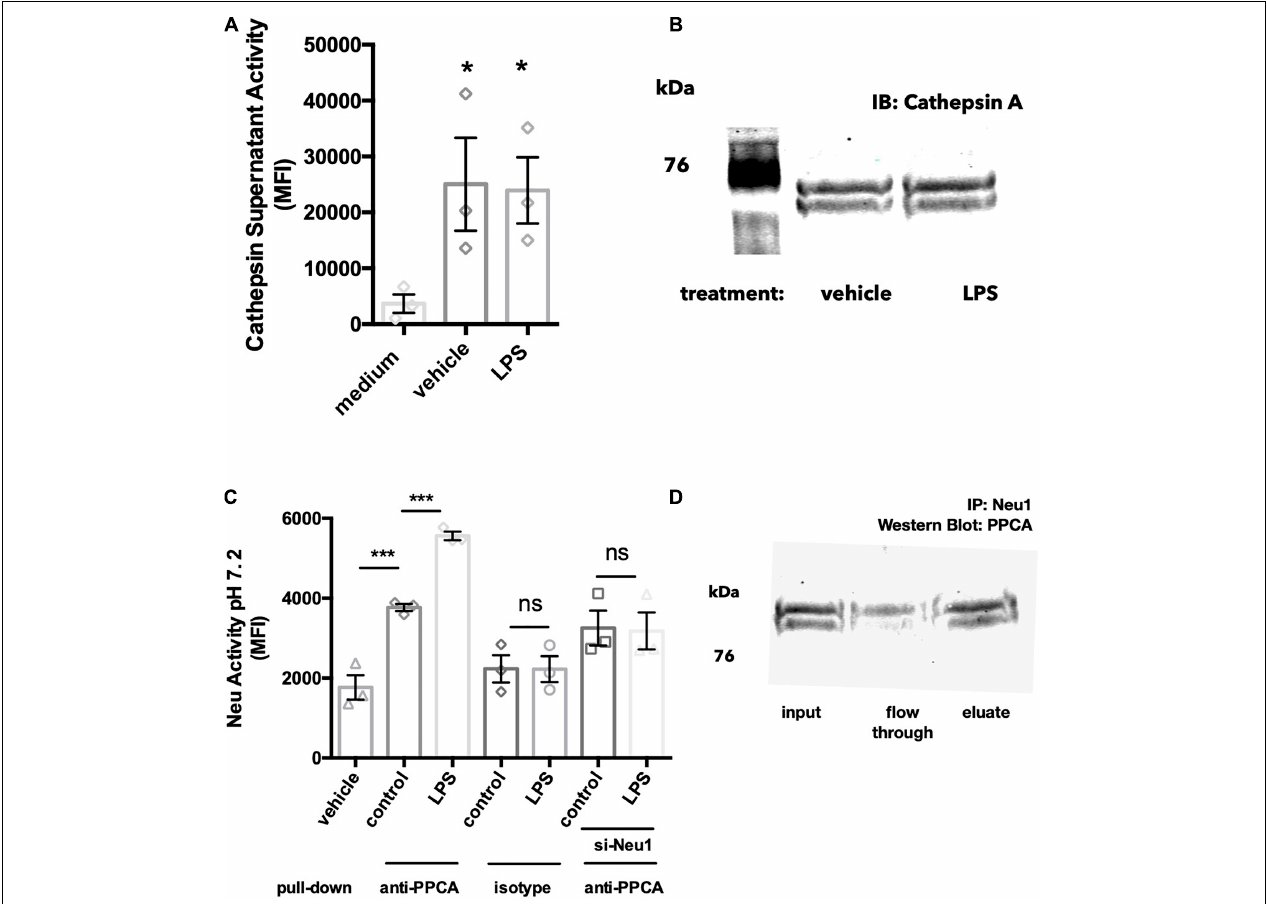
FIGURE 3 | Neu1 is released together with protective protein cathepsin A (PPCA). (A) Cathepsin activity assay measured by cleavage of substrate Z-Phe-Arg- 7-amido-4-methylcoumarin (Z-Phe-Arg-AMC) in acidic buffer (pH 4.5). BV-2 cells were treated with vehicle or LPS (100 ng/ml) for 18 h and supernatants were tested for cathepsin activity. Medium indicates a DMEM-only control with no cells added. Data presented as mean fluorescence intensities of at least 3 independent experiments ( ± S.E.M). Statistics: one-way ANOVA with Tukey’s post hoc analysis * p < 0.05 versus medium. (B) Western blot of 20-fold concentrated BV-2 culture supernatants, blotting against protective protein cathepsin A (PPCA). Blot representative of 3 similar Western blots. (C) Neuraminidase activity assays from protein G agarose pull downs of BV-2 culture supernatants: BV-2 microglia were treated with vehicle or LPS (100 ng/ml) over 18 h. In some experiments BV-2 were pre-treated with si-Neu1-targeting siRNA to reduce Neu1 levels. Culture supernatants were exposed to anti-PPCA or isotype control antibody, followed by protein G agarose pull down. Data presented as mean neuraminidase activity assays of three independent culture preparations ( ± S.E.M). Statistics: one-way ANOVA with